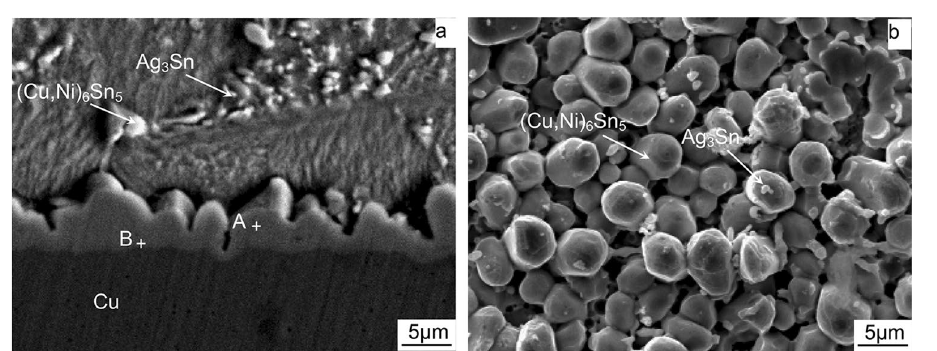
Figure 5. The interfacial microstructure of Sn2.5Ag0.7Cu0.1RE0.05Ni/Cu solder joints and EDS analysis (100cycles) ( a ) cross-sectional, ( b ) top view.